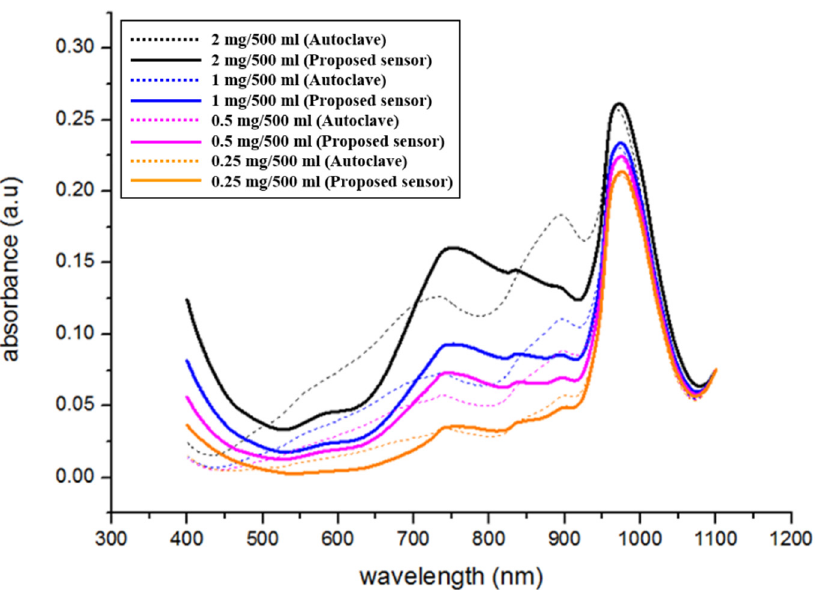
Figure 12. Comparison of the pretreatment performance between the optimized pretreatment method and the conventional method at different phosphorus concentrations.